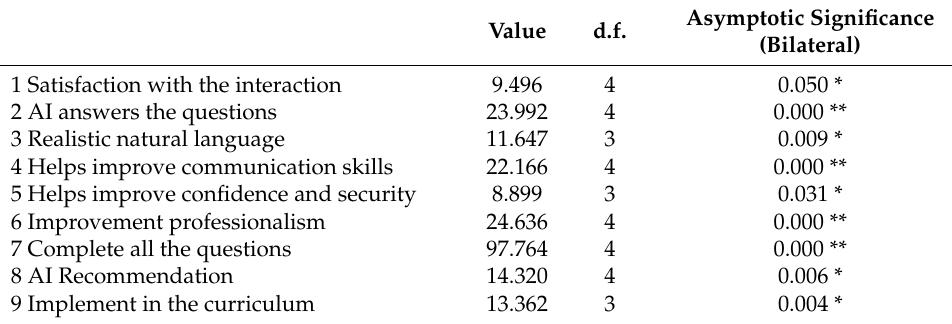
Table 8. χ 2 test. Diagnosis vs. questionnaire.